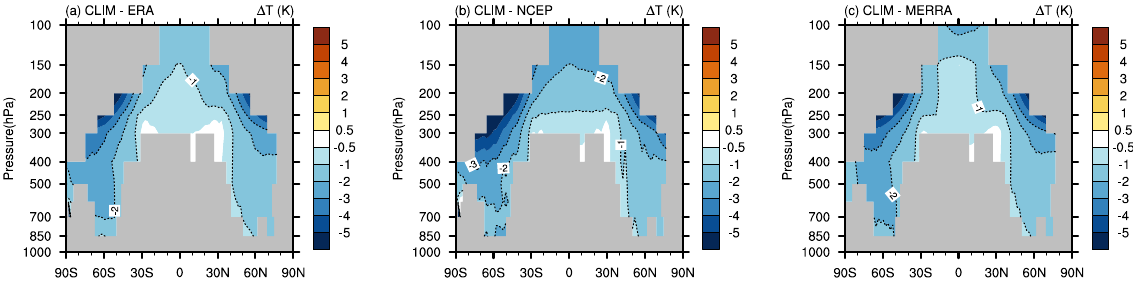
Figure 3. 5yr (2006–2010) mean, zonally averaged differences between temperature simulated by the free-running CAM5 (“CLIM”) and the (a) ERA-Interim (ECMWF Interim Reanalysis), (b) NCEP (National Centers for Environmental Prediction Reanalysis), (c) MERRA (Modern Era-Retrospective Analysis for Research and Applications). Units: K. Regions with mean ice crystal number concentration lower than 5 g − 1 in the CLIM simulation are masked out in gray.